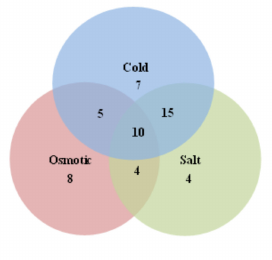
Figure 6. The number of genes involved in two or three abiotic stresses at the same